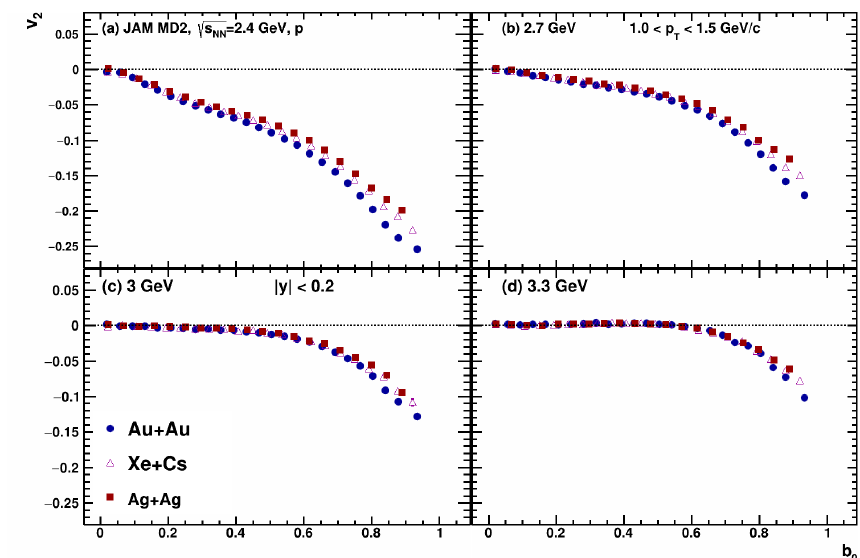
Figure 24. Scaled impact parameter b 0 dependence of elliptic flow v 2 of protons in the transverse momentum interval 1.0 < p T < 1.5 GeV/c at mid-rapidity | y cm | < 0.2 from Au + Au (closed circles), Xe + Cs (open triangles), Ag + Ag (closed boxes) collisions at energies 2.7 GeV (panel ( b )), 3 GeV (panel ( c )) and 3.3 GeV (panel ( d )). The results for JAM model with hard momentum dependent mean-field MD2 ( K 0 = 380 MeV) EOS.